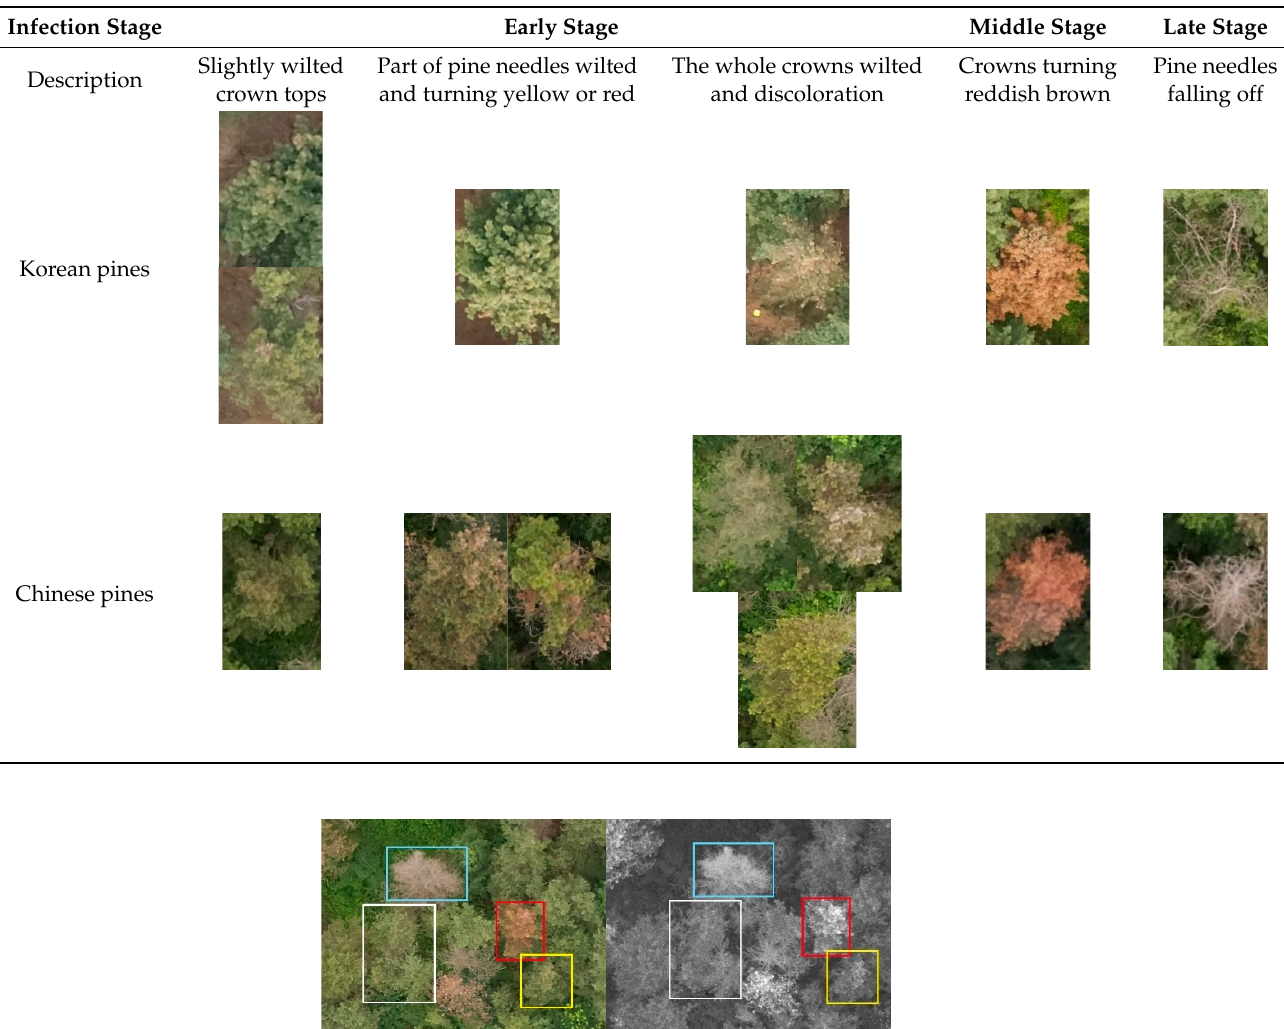
Table 3. Infected pine trees in KP and CP datasets.